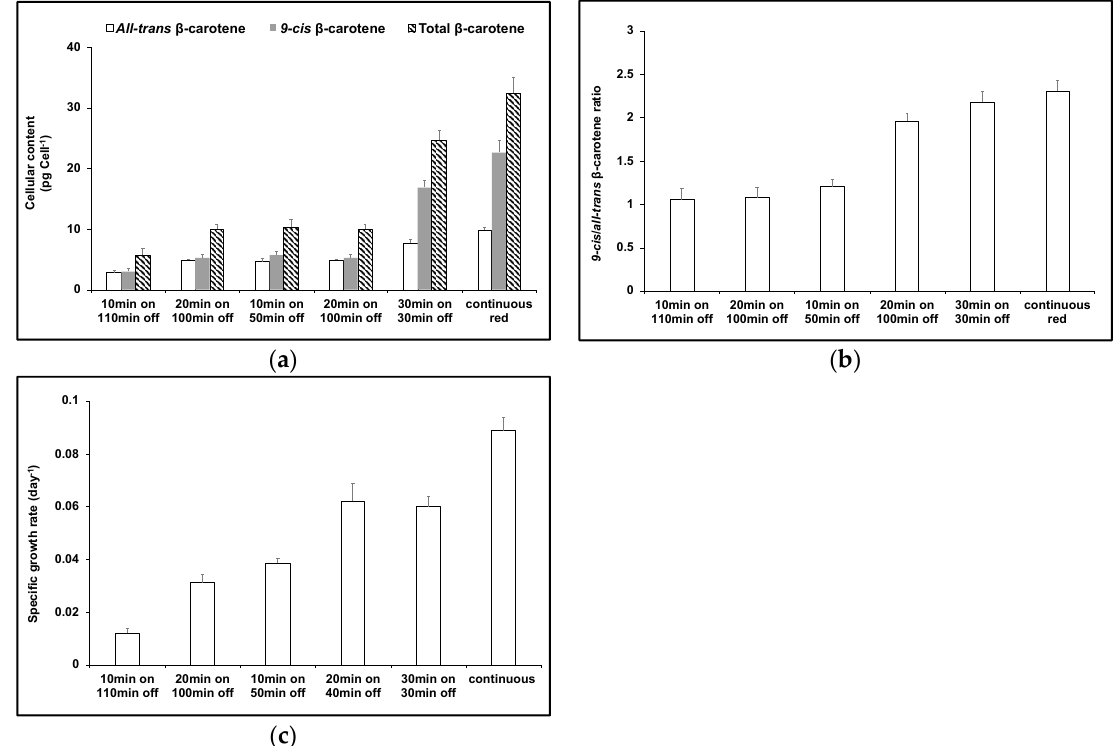
Figure 4. Effect of cultivating D. salina under different red light/dark cycles. ( a ) Cellular content of 9-cis β C, all-trans β C and total β C and ( b ) 9-cis / all-trans β C ratio and ( c ) specific growth rate of D. salina cultures grown under different light/dark cycles of red LED light supplied at 500 µmol m − 2 s − 1 . Cultures of D. salina were grown to a cell density of ~0.2 million cells mL − 1 under white LED light and then transferred into red LED light growth cycles of di ff erent duration. Carotenoids were analysed after 6 days